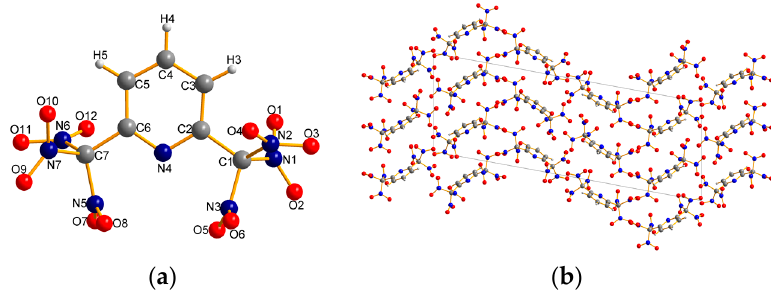
Figure 3. ( a ) Molecular structure of 2 ; ( b ) packing diagram of 2 viewed down the a-axis.